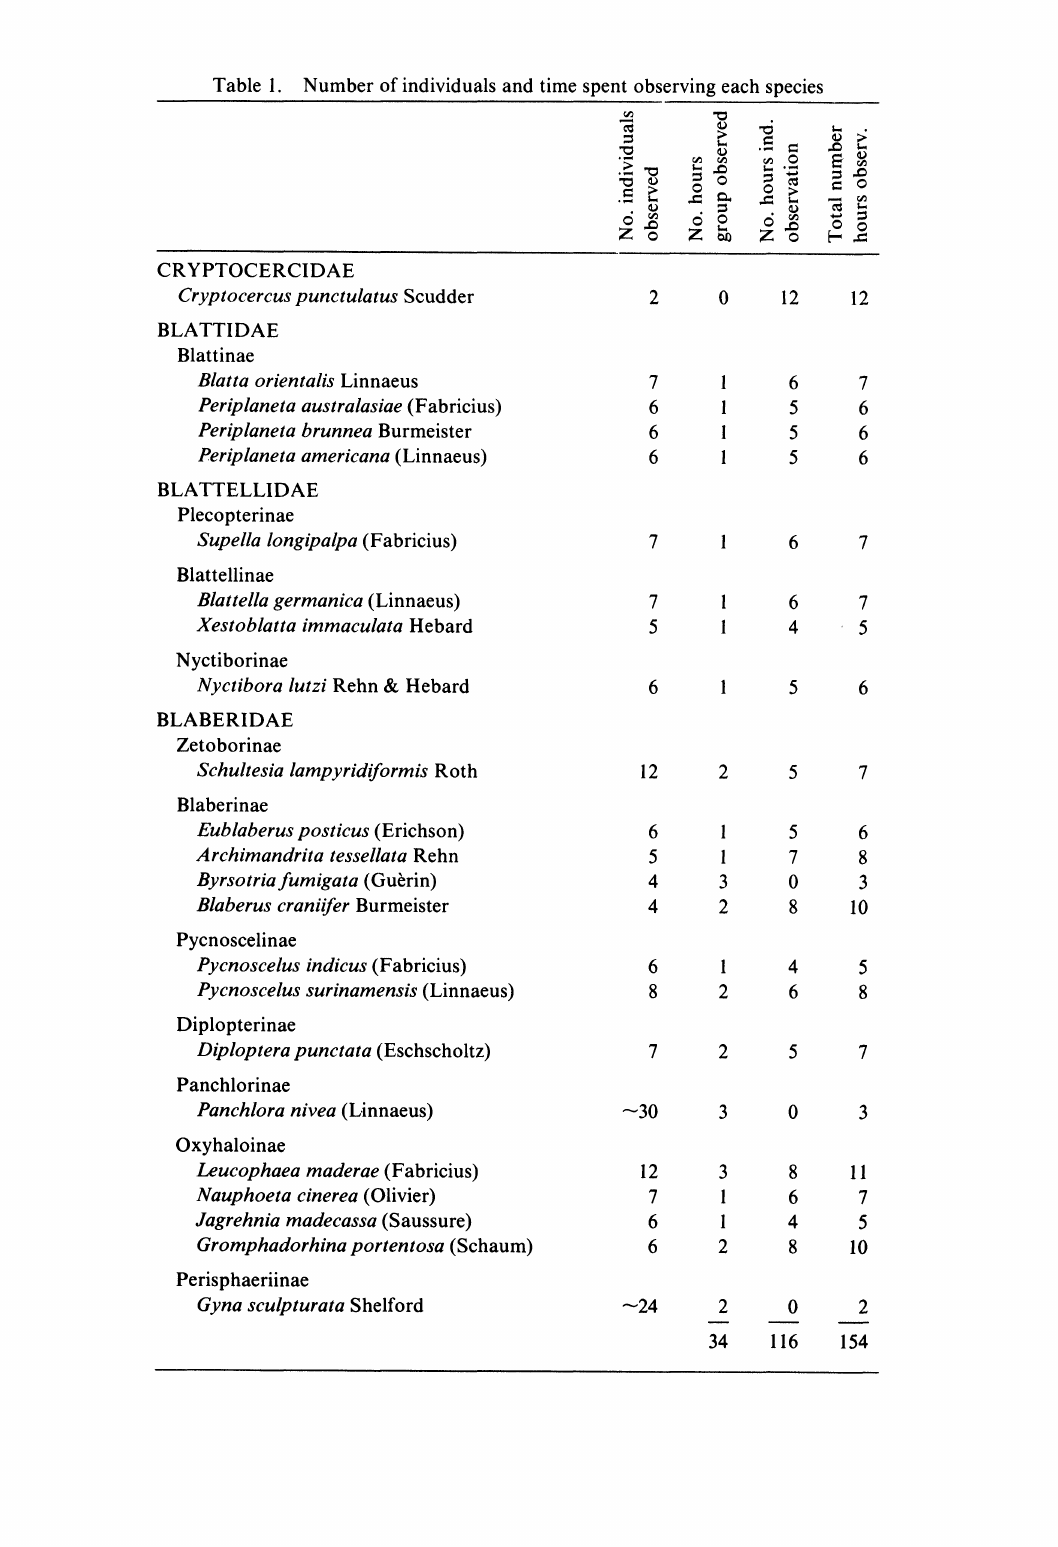
Table 1. Number of individuals and time spent observing each species